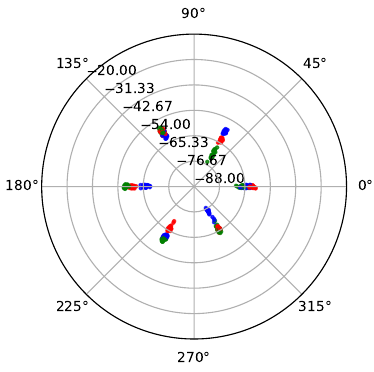
Figure 8. Directionality of ESP32 with the onboard PCB antenna. RSS measurements in dBm unit collected at different angular positions are plotted in different colors with red for channel 37, green for channel 38, and blue for channel 39. Transmitter and receiver devices are 1 m apart in